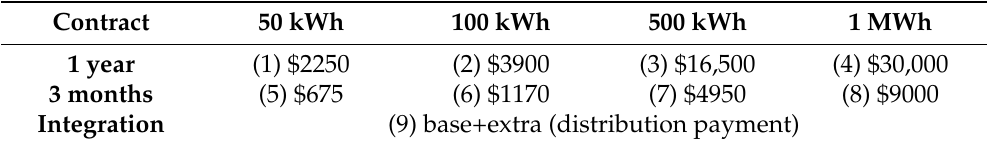
Table 1. An example of CESS price